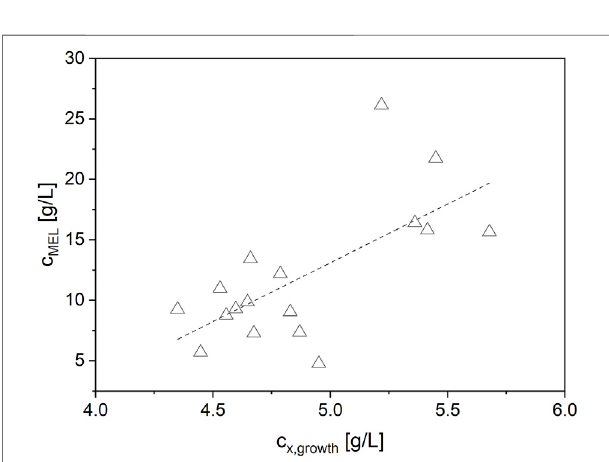
FIGURE 3 | Positive correlation between the target values biomass and MEL concentration. Higher biomass concentrations at the end of the growth phase lead to higher MEL concentrations during production